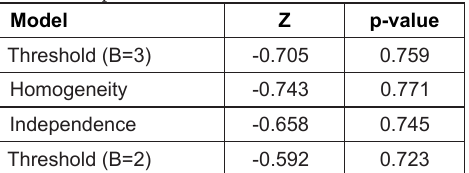
Table 30. Tests for randomness of collared caribou for the Cape Bathurst 2009 data